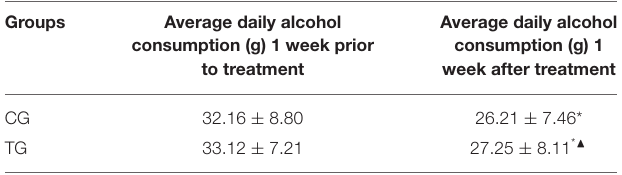
TABLE 1 | Comparison of curative effect between the control group and the treatment group examples (%). Groups